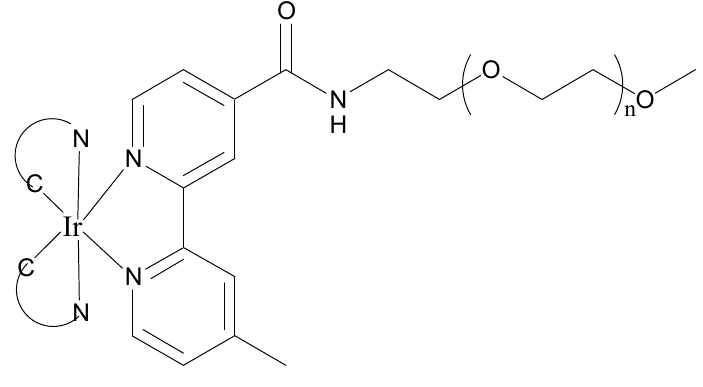
Figure 25. Ir(III) PEG complexes as new 1 O 2